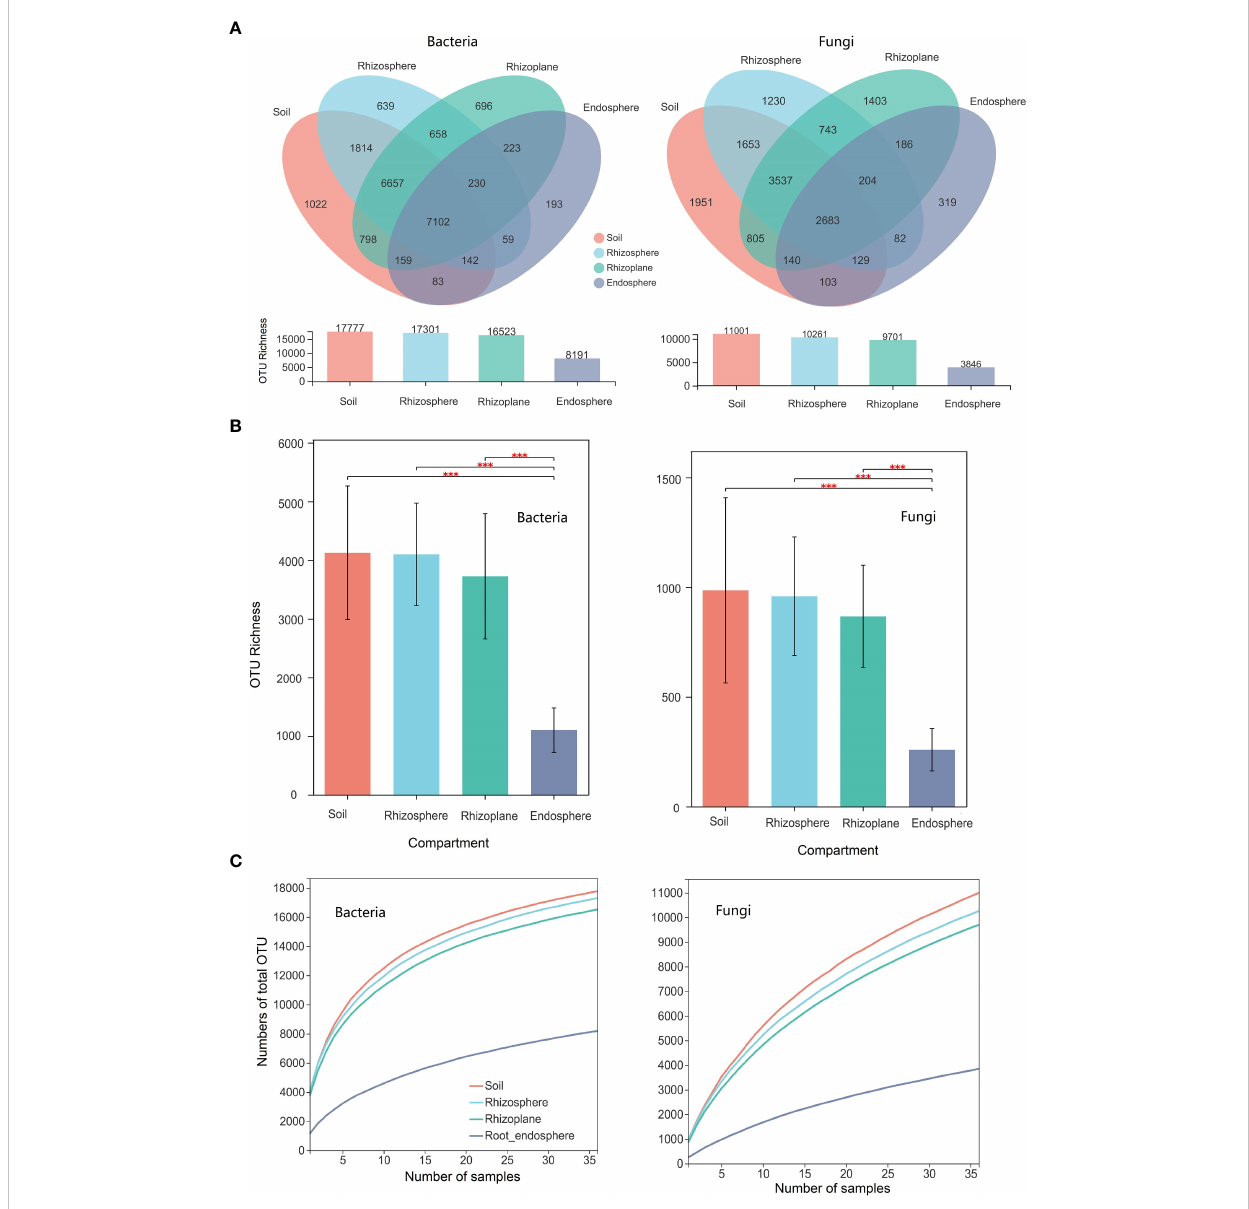
FIGURE 1 Microbial diversity of different compartments (soil, rhizosphere, rhizoplane, and root endosphere) of rubber tree root. (A) : Venn diagram depicting the shared and speci fi c number of operational taxonomic units (OTUs) across compartments; (B) : Bar plot showing the OTU richness of microbial communities of different compartments; (C) : Cumulative numbers of OTUs for all samples ( g -diversity) of different compartments of the rubber tree root. *** p <